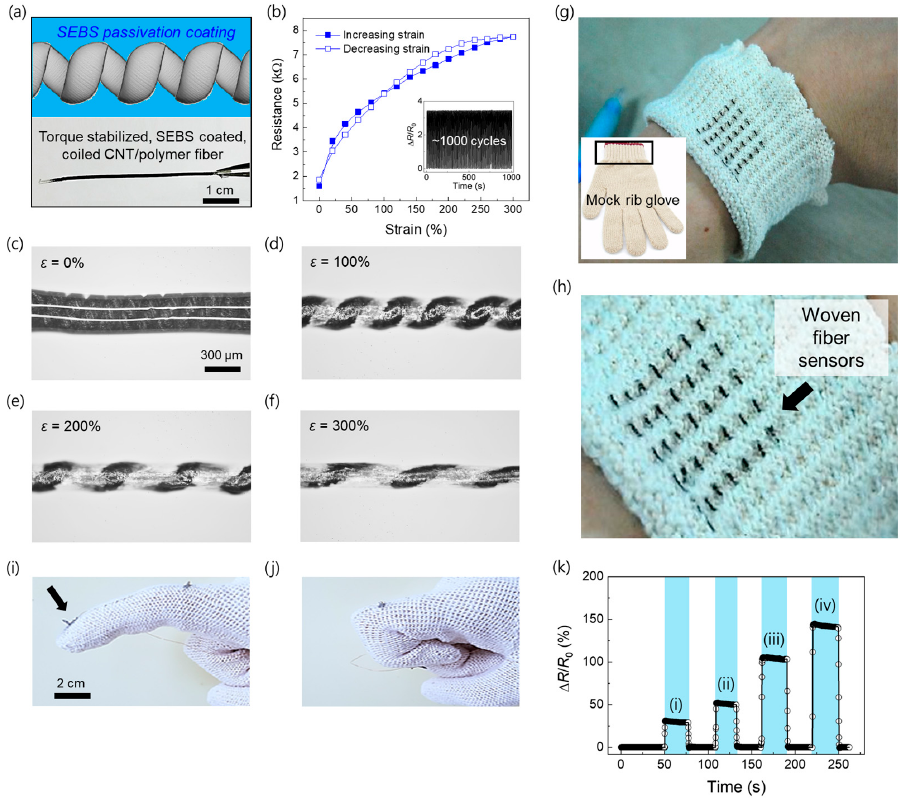
Figure 3. Demonstration of torque stability and weavability of the coiled fiber sensors for wearable applications. ( a ) Schematic shows SEBS package − coated coiled CNT/polymer fiber sensor, and ( b ) its resistance with respect to tensile strain. The inset of ( b ) shows the resistance change ratio during 1000 repeated loading/unloading with 300% strain. Photographs show the SEBS package − coated, coiled CNT/spandex fiber sensor at different strain values: ( c ) 0%, ( d ) 100%, ( e ) 200%, and ( f ) 300%. The photographs in ( g ) present seven coiled CNT/spandex fiber sensors woven into the wristband part of a mock ribbed glove to replace the mock rib fibers; ( h ) shows the magnified image. Photographs present finger movements ( i ) before and ( j ) after bending and ( k ) corresponding resistance change versus time at different finger bending angles ((i) 25 ◦ ; (ii) 50 ◦ ; (iii) 75 ◦ ; and (iv) 100 ◦